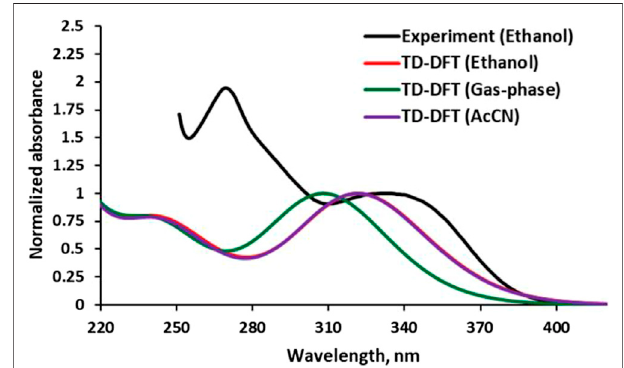
FIGURE 4 | Experimental (conc. ∼ 1.10 × 10 − 5 mol/dm 3 ) and calculated electronic absorption spectra of APG in different media.